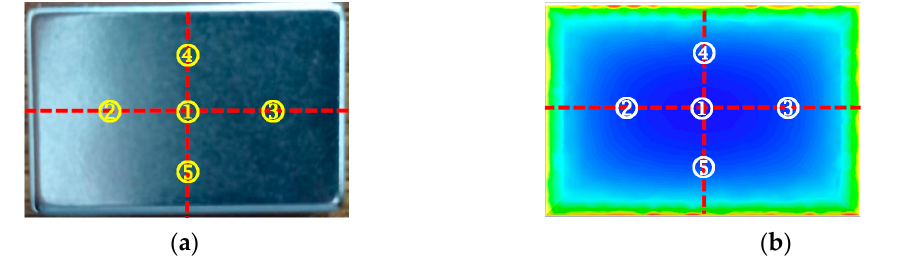
Figure 2. Test points and simulation results of surface magnetism of permanent magnets. ( a ) Physical permanent magnet. ( b ) Surface magnetic simulation results.